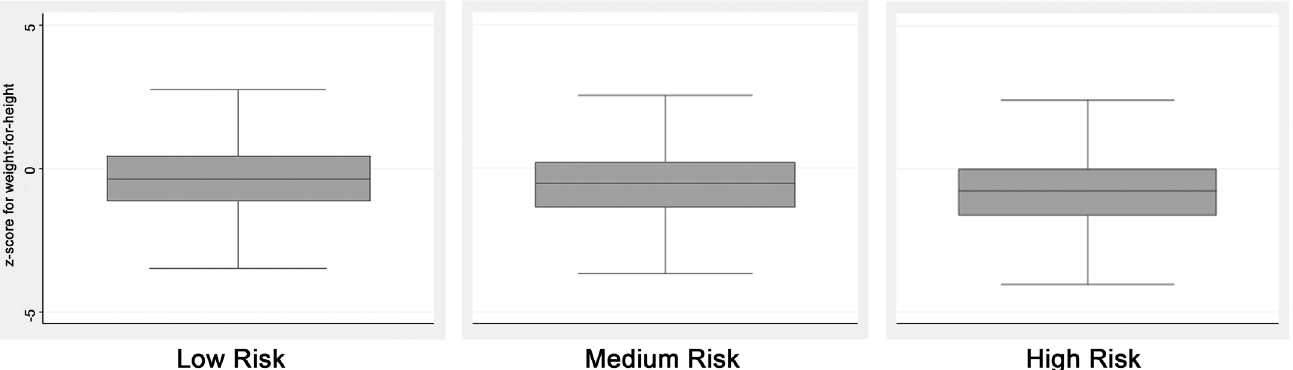
Fig 3. Box plot of z-score of weight-for-height of children in 0 – 59 months by level of Household Environment Health Risk Index in Northeast India. Source: Based on authors computation from National Family Health Survey 3 (NFHS-3), 2005 – 06